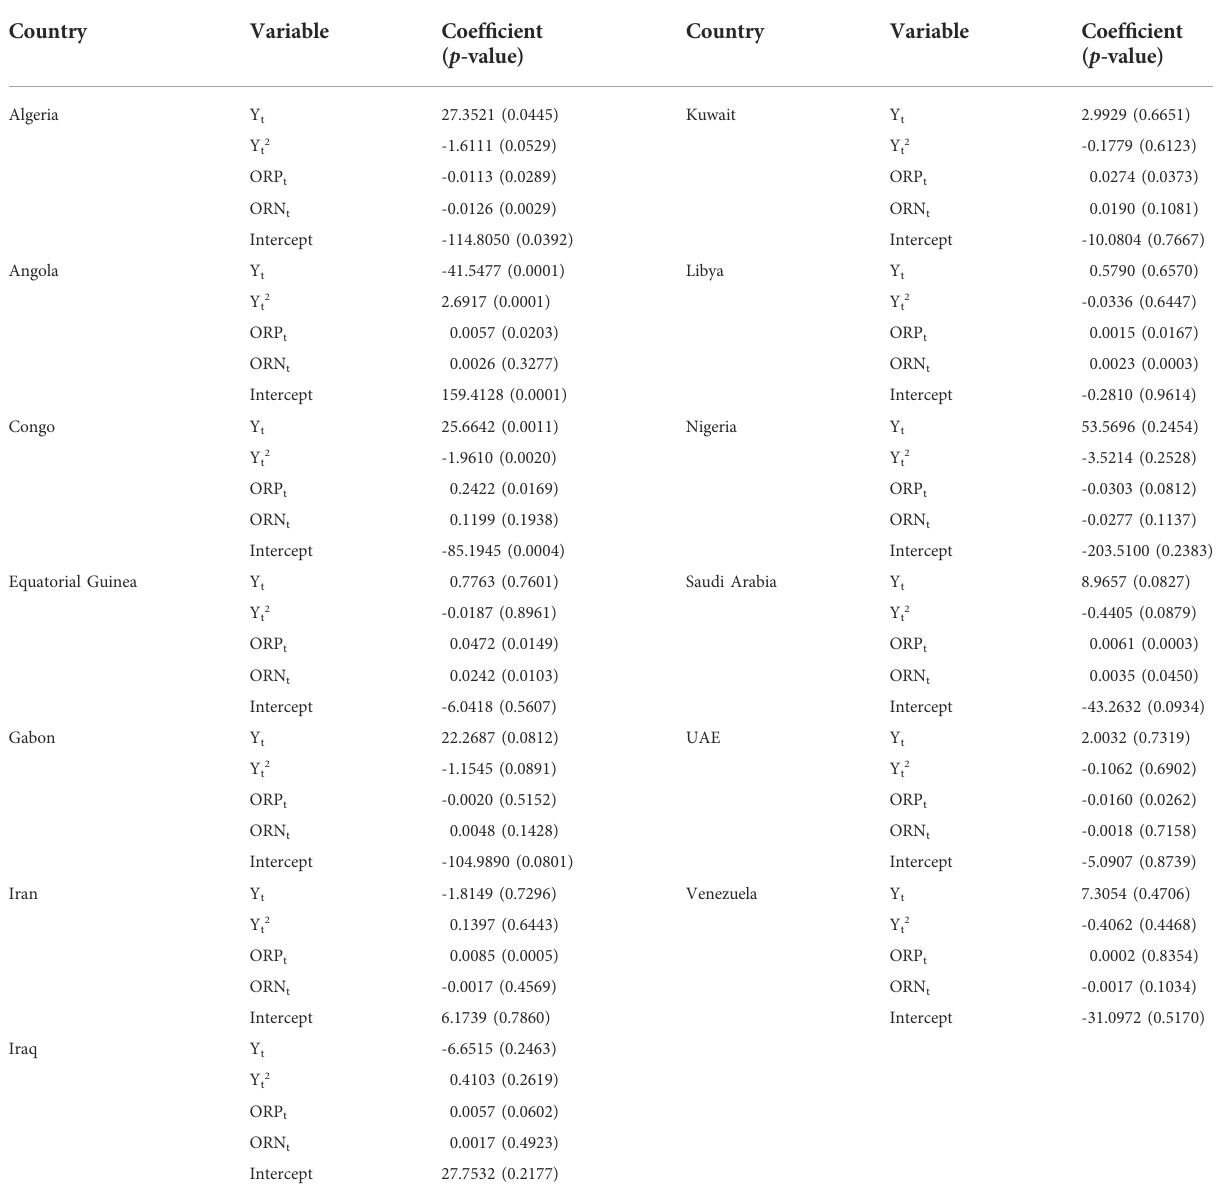
TABLE 3 The long run